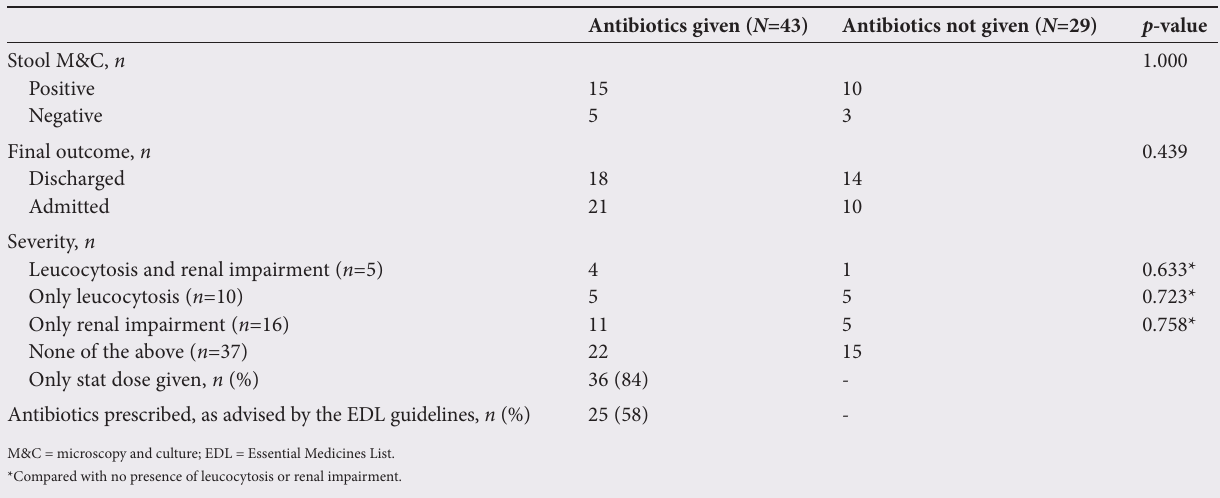
Table 2. Use of antibiotics in all